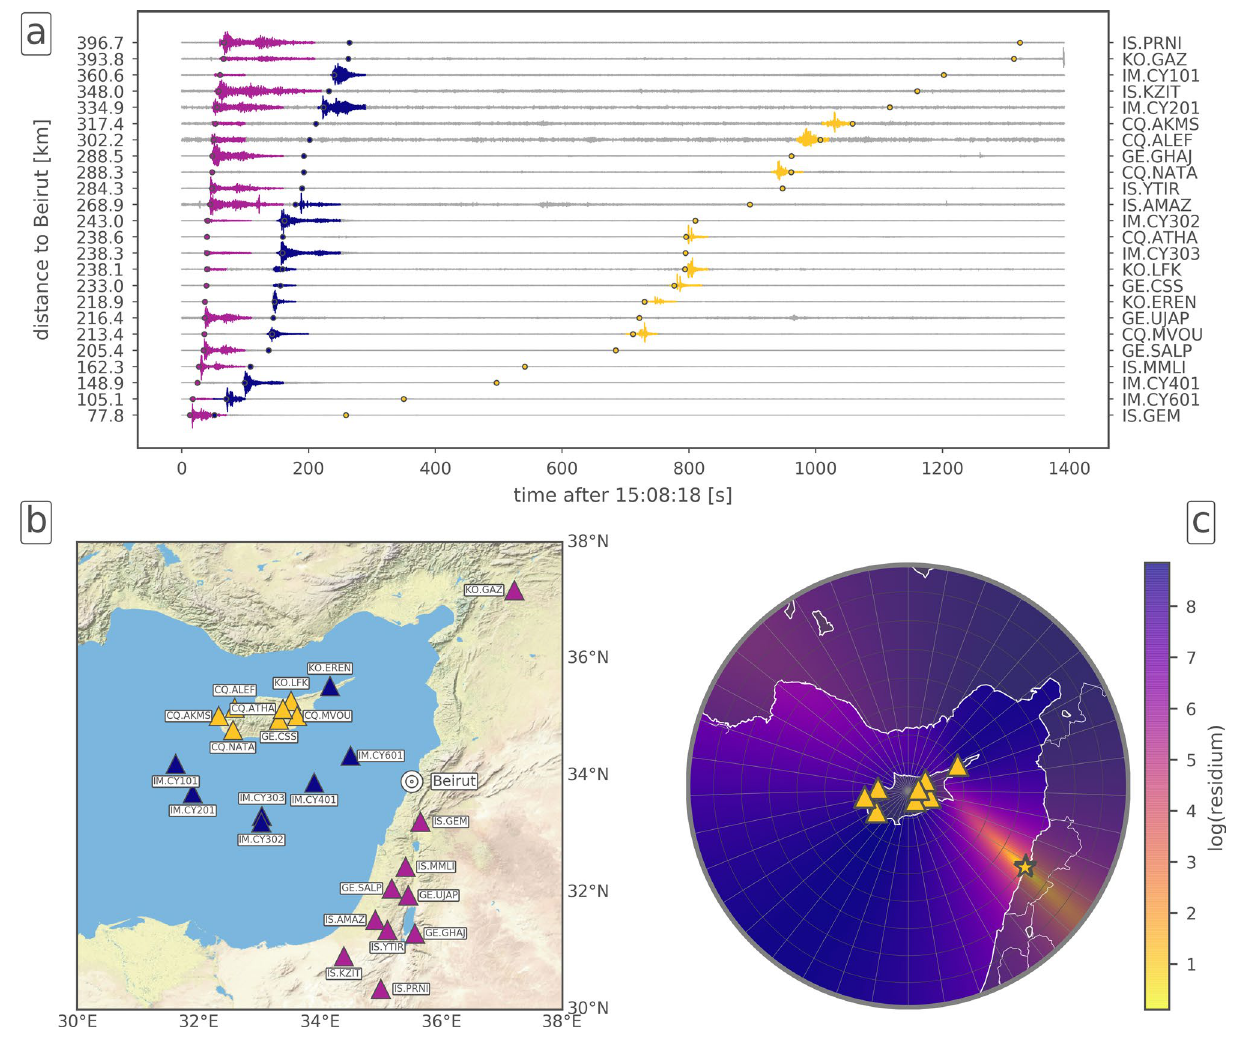
Figure 1. Data from regional seismic stations. ( a ) Waveforms of the seismic stations. Colored circles (purple, blue, yellow) represent theoretical arrivals of phases propagating with seismic (6.0 km/s), hydroacoustic (1.5 km/s) or acoustic (0.3 km/s) velocities. Observed waveform arrivals of seismic, hydroacoustic or acoustic phases are color coded in the respective colors. Waveforms are bandpass-filtered in the frequency band 0.5 to 8.0 Hz. ( b ) Seismic stations with distances of up to 400 km from the explosion site in Beirut. Station colors represent the type of the dominant observed phase (seismic = purple, hydroacoustic = blue, acoustic = yellow), see also subfigure ( a ). ( c ) Localization of the event based on acoustic phases (marked yellow in subfigure ( a )) detected on the eight seismic stations at the island of Cyprus for details). Background colors represent a residuum, which defines the optimal localization at its smallest value. The best localization is found at 33.863 E, marked as yellow star at Beirut (see “Seismoacoustic localization procedure for stations located on Cyprus” section for details on the localization procedure). Maps in subfigures ( b ) and ( c ) are created using the Matplotlib Basemap Toolkit (https:// matpl otlib. org/ basem ap/, last access: 2021/02/15). Background topography in subfigure (b) is available from the Esri ArcGIS Map Service; country and coastline outlines used in subfigure ( c ) are provided by the Global Self-consistent, Hierarchical, High-resolution Geography Database (GSHHG) and by the Generic Mapping Tool (GMT),